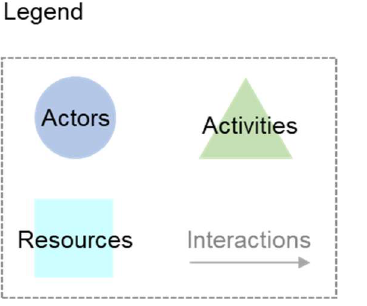
Fig. A3.5. Individual mental models of three NGOs’